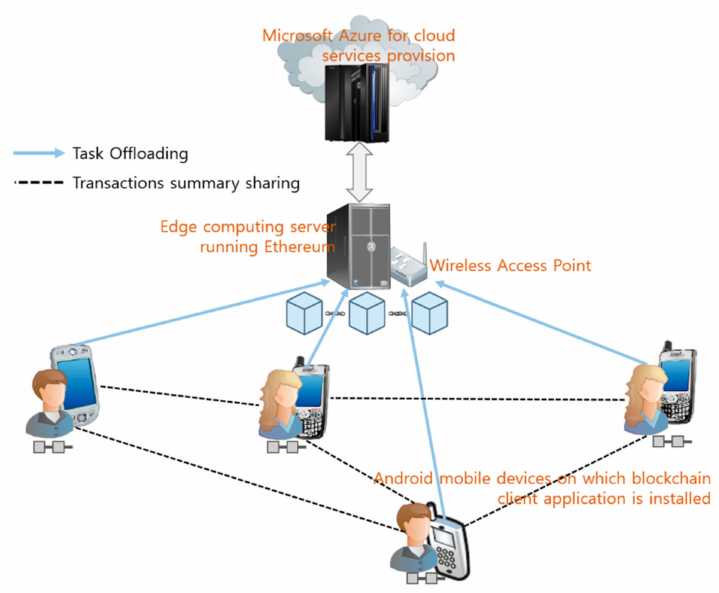
Figure 9. Prototype implementation